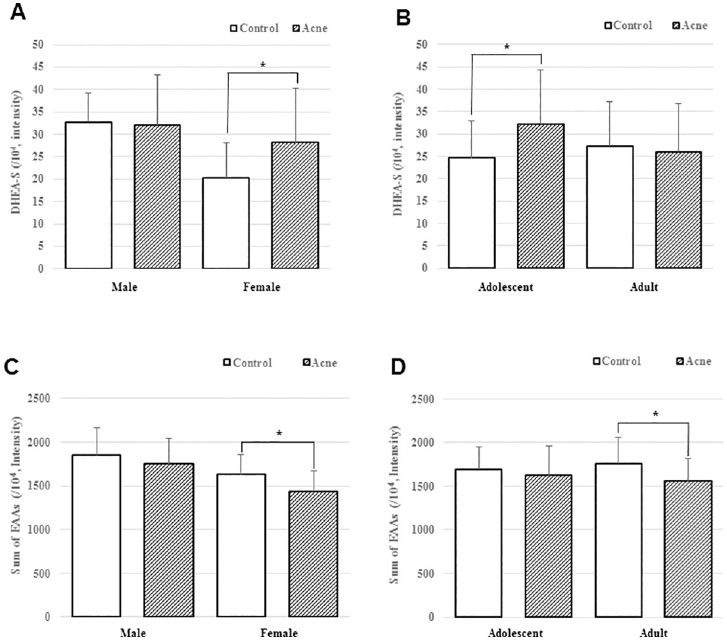
Fig 1. Intensity of DHEA-S and sum of EAAs in control and acne groups. (A, C) Male subjects in control group vs. acne group and female subjects in control vs. acne group. (B, C) Adolescents in control vs. acne group, and adults in control vs. acne